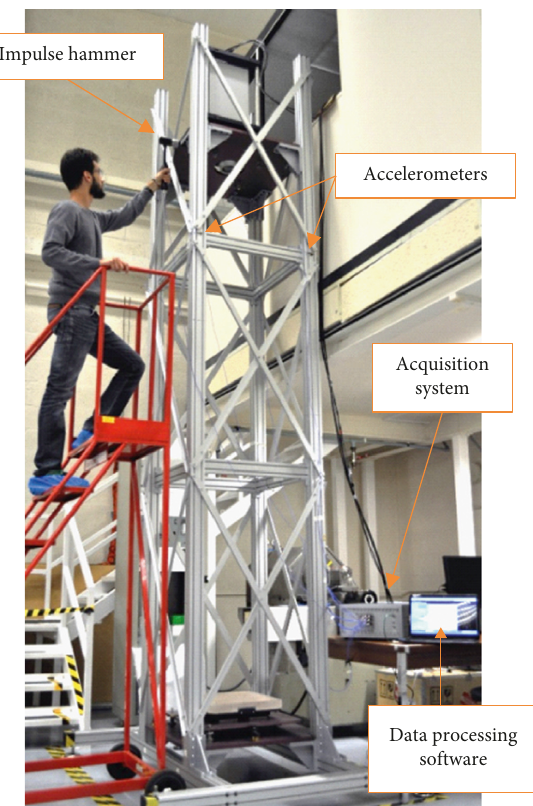
Figure 7: Experimental setup with equipment